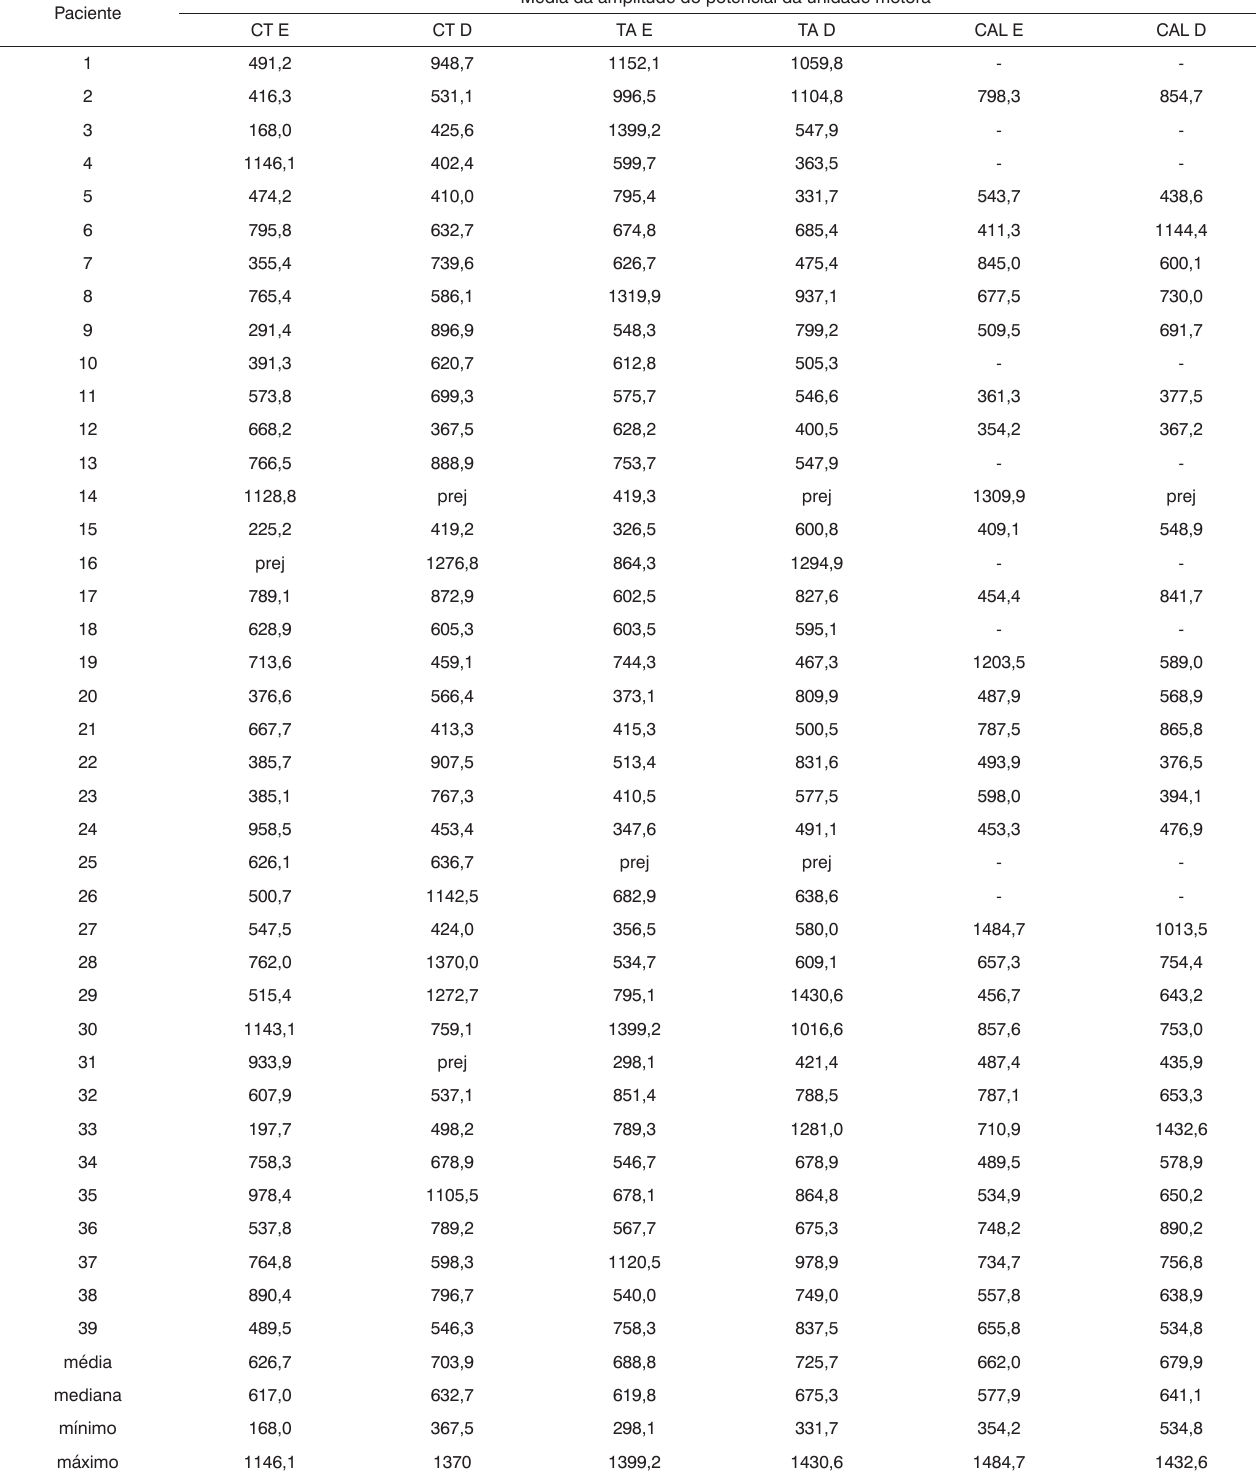
Tabela 2. Média da amplitude do potencial da unidade motora (em